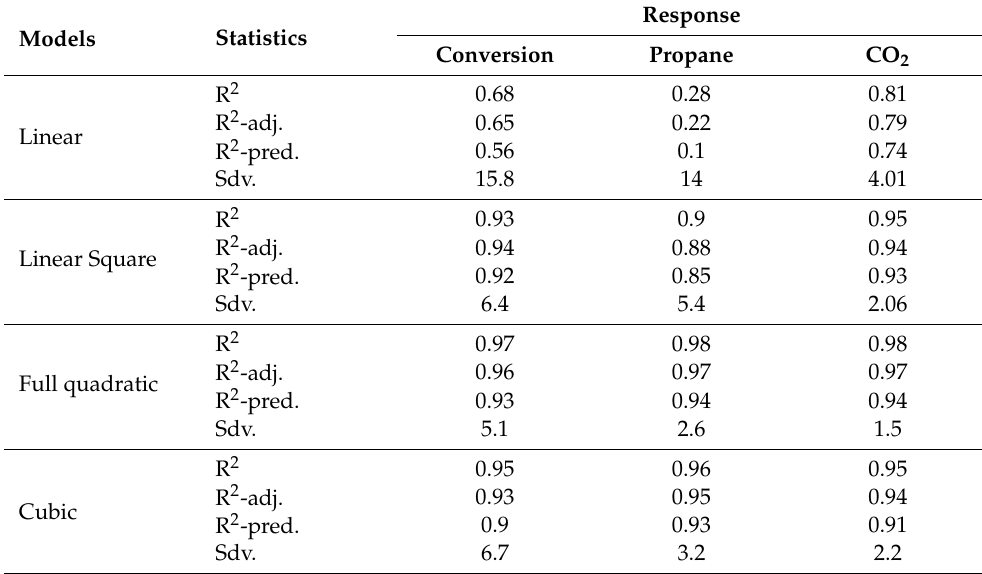
Table 6. Statistical analysis of models for butyric acid conversion and yields of propane and CO 2 under nitrogen gas atmosphere.